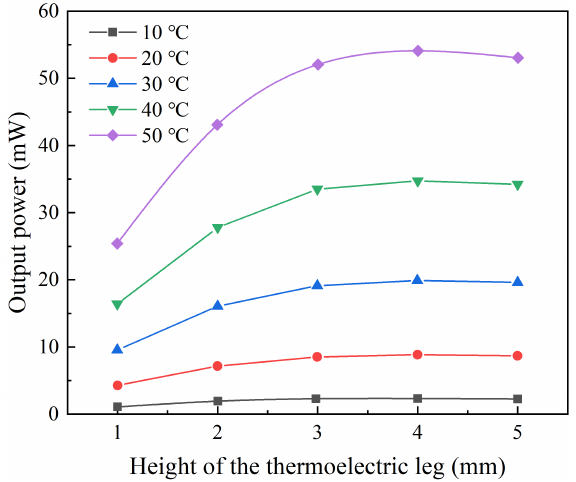
Figure 5. The relationship between the thermoelectric leg height and output power